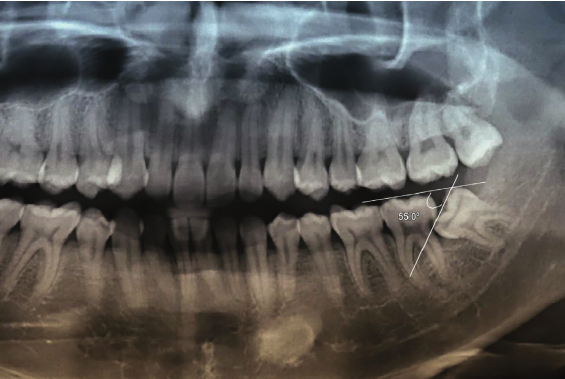
Figure 2: A right M2M with distal caries and mesial angulation of the adjacent